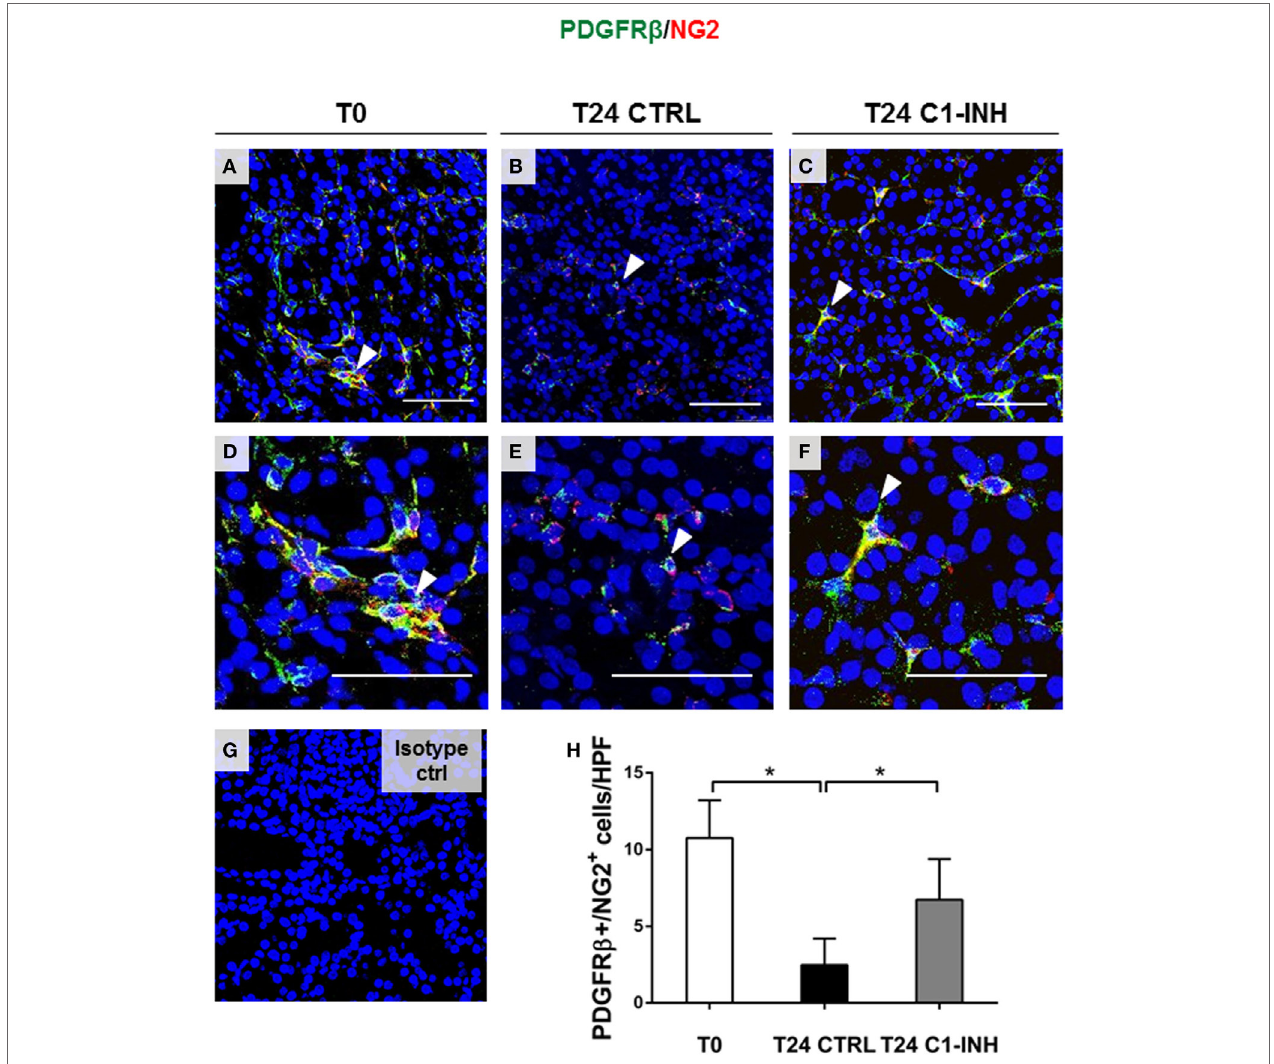
FigUre 2 | C1-INH preserved phenotype of double-positive PDGFR β /NG2 pericytes after I/R injury. Renal tissues were double stained for the pericyte markers PDGFR β (green) and NG2 (red). (a,D) Normal kidney, before ischemia (T0) showed the colocalization of the two signals in peritubular capillaries [arrowhead in (a,D) in merged images shown the overlap between PDGFR β and NG2]. The number of peritubular capillaries-pericytes was reduced after 24 h of I/R (b,e) , in contrast, 24 h of C1-INH treated pigs showed PDGFR β /NG2 marker restoration (c,F) . (h) Results are expressed as median ± interquartile range of the numbers of PDGFR β + /NG2 + cells/high power fields (HPF) of five independent pigs for each group, * p < 0.05. Magnification, 630 × , scale bar = 50 μ m. (g) Isotype control staining for